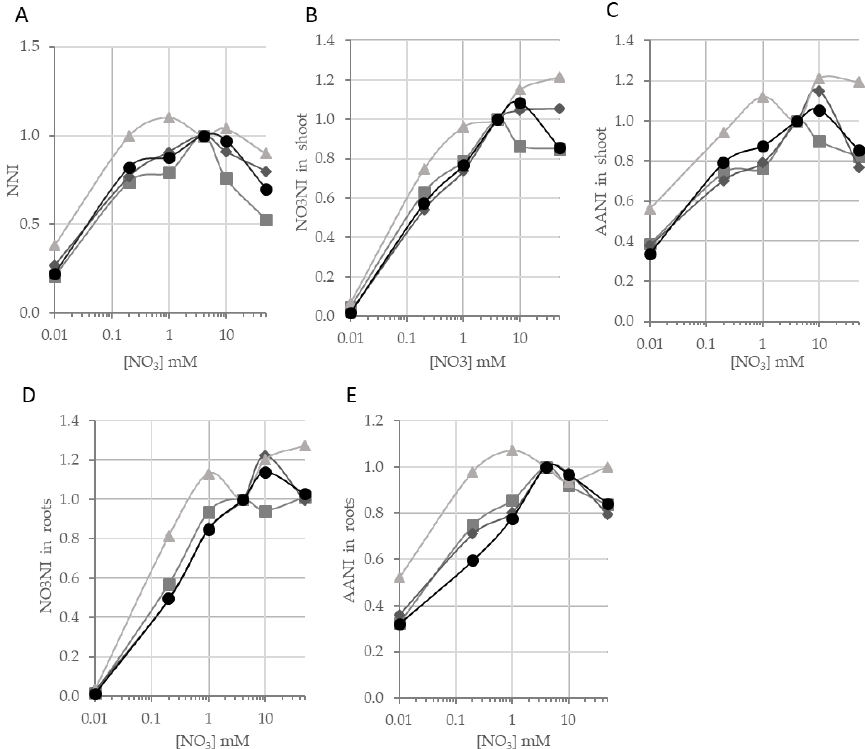
Figure 6. Nutrition Index of different N pools in four Arabidopsis accessions. On the y axis, Nitrogen Nutrition Index (NNI, ( A ), Nitrate Nutrition Index (NO3NI, ( B ) in shoot, ( D ) in roots) and Amino Acids Nutrition Index (AANI, ( C ) in shoot, ( E ) in roots) are reported, plotted against environmental NO 3 concentration on a logarithmic scale. Accessions are shown by squares, diamonds, triangles, and circles in different shades of grey for Bur-0 , Col-0 , Cvi-0 and Ge-0 , respectively.